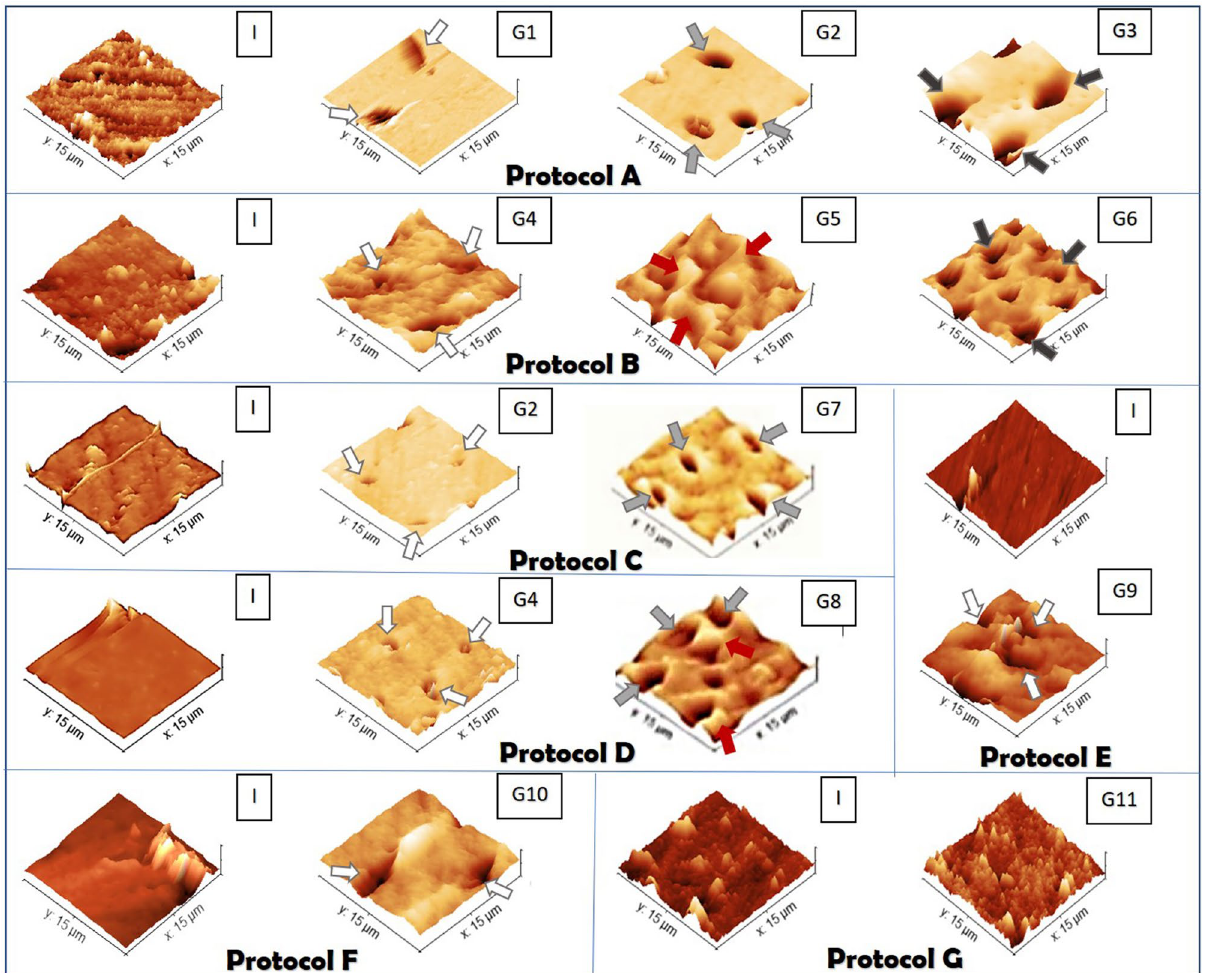
Figure 3. Atomic force micrographs showing topography of the dentin surface before (initial—I) and after immersion in the irrigation solutions (G1–G11; horizontal axis) as indicated in Protocols A–G detailed in Table 1. White arrows indicate less evident dentinal tubules in groups with NaOCl or chelator single flush. Light grey and dark grey arrows expressed a wider range and progressive widening of the dentinal tubules when both irrigants were used in a Protocol alone or adding NaOCl as a final flush, respectively. In protocol NaOCl+ chelator, (5%) NaOCl promoted a rough surface of dentin indicated by red arrows.